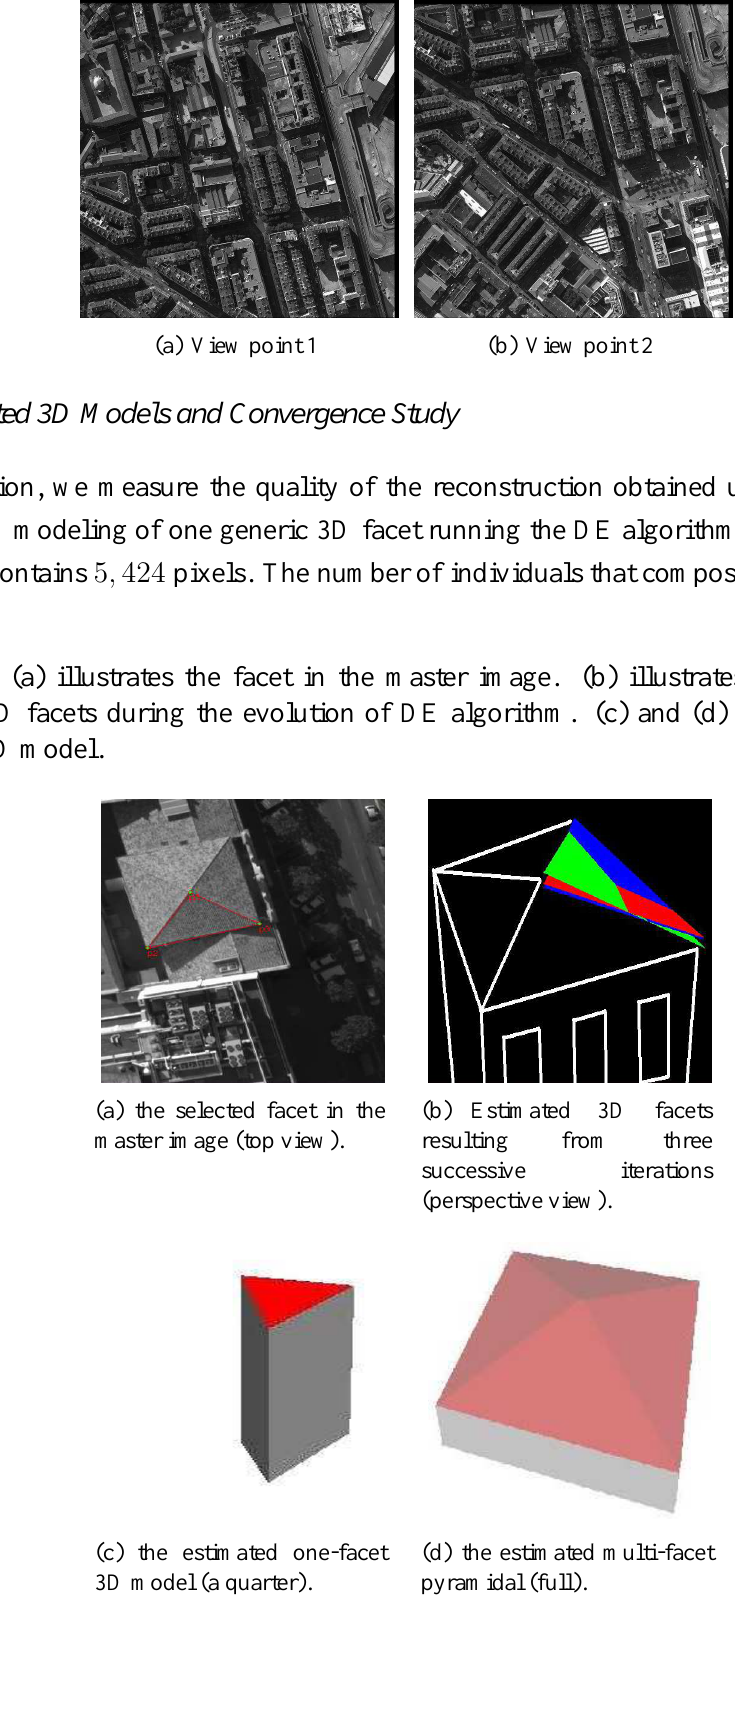
and N × N = 4 , 158 × 4 , 160 where N c r c r